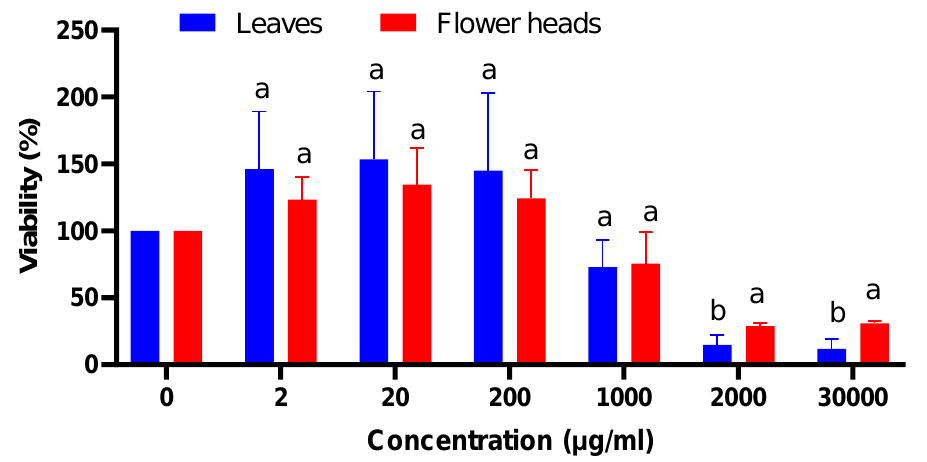
Figure 4. Cytotoxicity of C. alpina extracts towards THP-1 cells (by the student t-test, different letters indicate significant difference between plant parts in the same concentration (a and b), p ≤ 0 .05.).